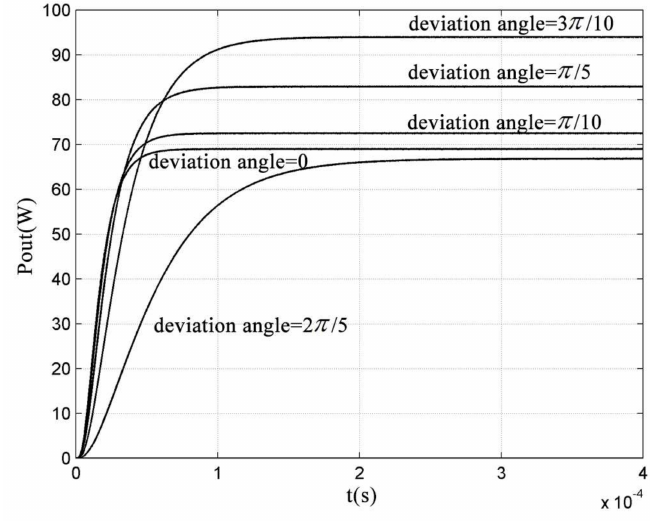
Figure 2. Output power against time with different deviation